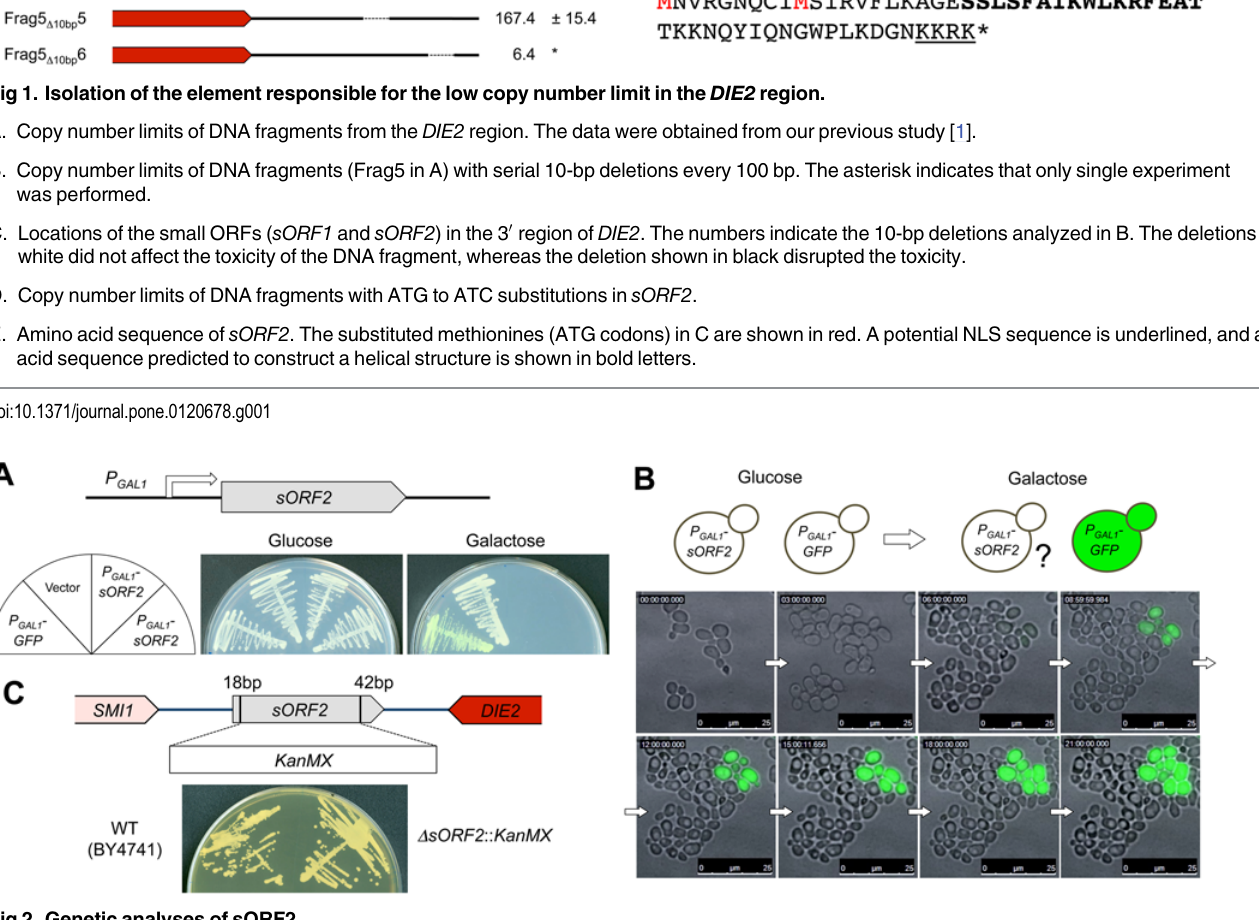
Fig 2. Genetic analyses of sORF2. A. Overexpression of sORF2 from the GAL1 promoter ( P GAL1 ). The construct used in this experiment is shown. Cells with pTOW-P GAL1 -sORF2 ( P GAL1 - sORF2 ) were streaked onto SC-glucose and SC-galactose plates. Two independent plasmid clones were analyzed. pTOW40836 (Vector) was used as B. Time-lapse imaging of cells after the induction of sORF2. The cells with pTOW-P GAL1 -sORF2 ( P GAL1 -ORF2 ) and pTOW-P GAL1 -GFP ( P GAL1 -GFP ) were cul- tured in SC-glucose mixed at a ratio of 10:1 and then cultivated in SC-galactose medium. P GAL1 -GFP was used to monitor the induction of P GAL1 . The cel- C. Deletion of sORF2 . The construct used to delete sORF2 from the chromosome is shown. The strain with sORF2 deleted was streaked onto a YPD agar plate. The strain BY4741 was used as a wild-type